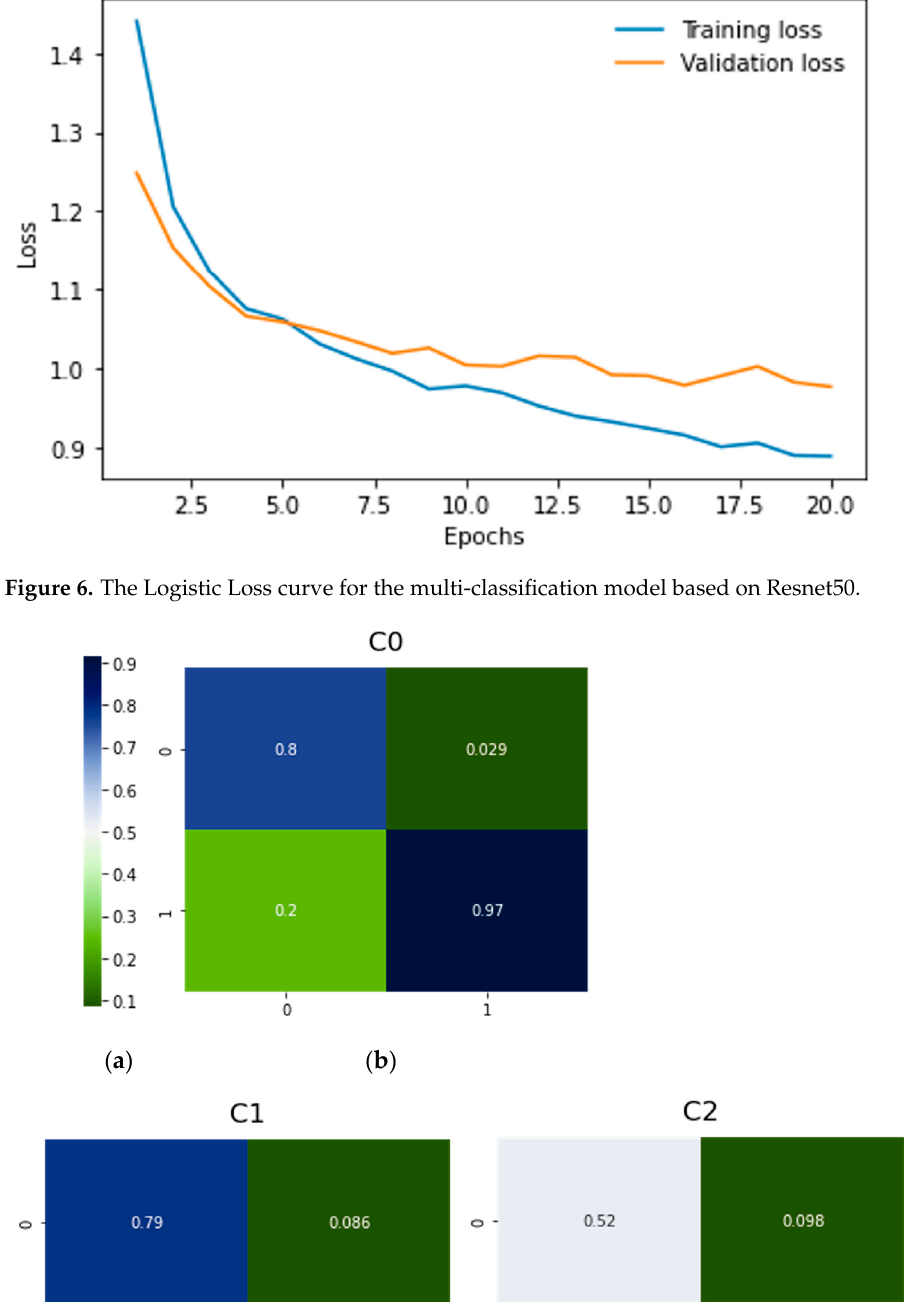
Figure 7. The multi-classification model based on Resnet50. The color scheme for confusion matrices ( a ); the confusion matrices for C0 ( b ), for C1 ( c ), and C2 ( d ) classes.